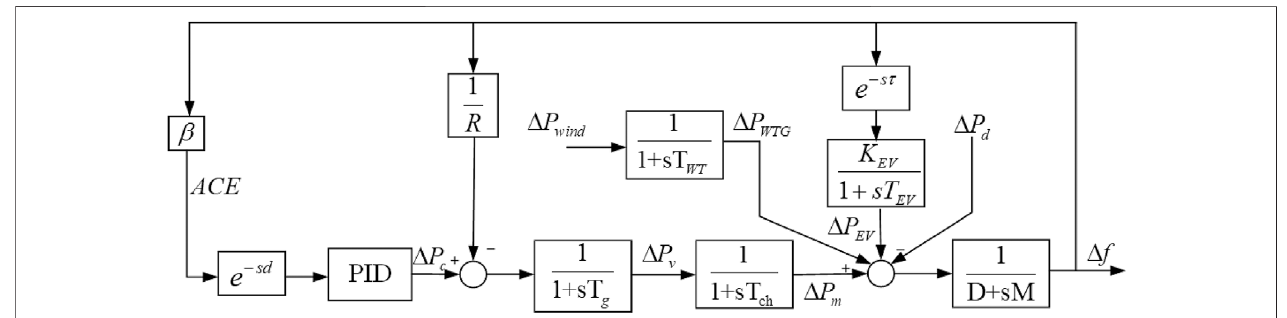
FIGURE 1 | Frequency regulation scheme of the power system with an EV aggregator.